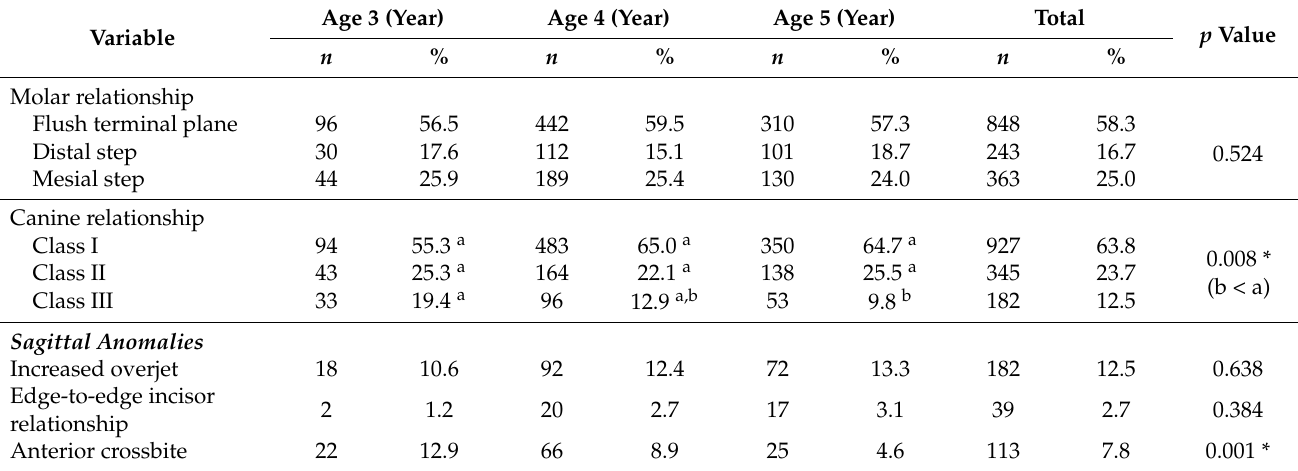
Table 2. The composition and prevalence of occlusal